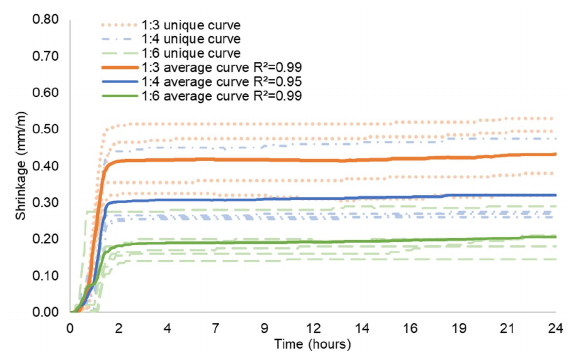
Figure 12. Early shrinkage curves of cement mortars exposed to 5 m/s wind. NOTE: dotted lines indicate individual tests, continuous ones are their respective average curves and their legend contains their linear R used to find shrinkage speed.